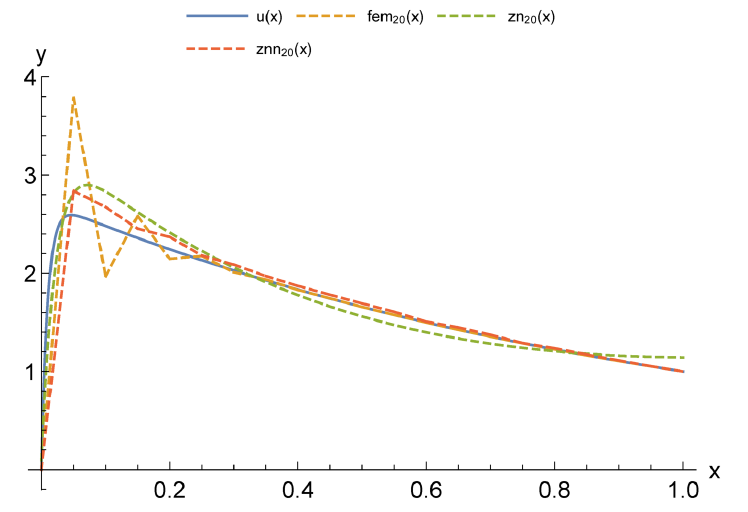
Figure 12. Plots of parametric FEM neural network solution znn 20 ( x ) (37) as applied to parameterized problem (30), FEM solution fem 20 ( x ) and neural network FEM solution smoothing zn 20 ( x ) (39) as applied to problem (30) (parameter value s = 0.01; number of elements K = 20), and its exact solution u ( x ) , corresponding to dashed lines and solid line,